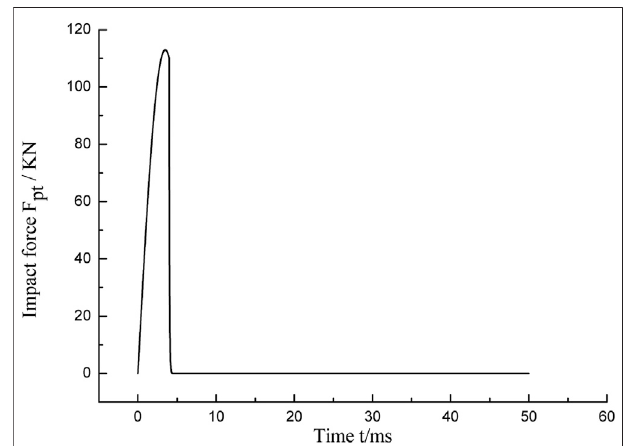
FIGURE 2 | Simulated impact signal.